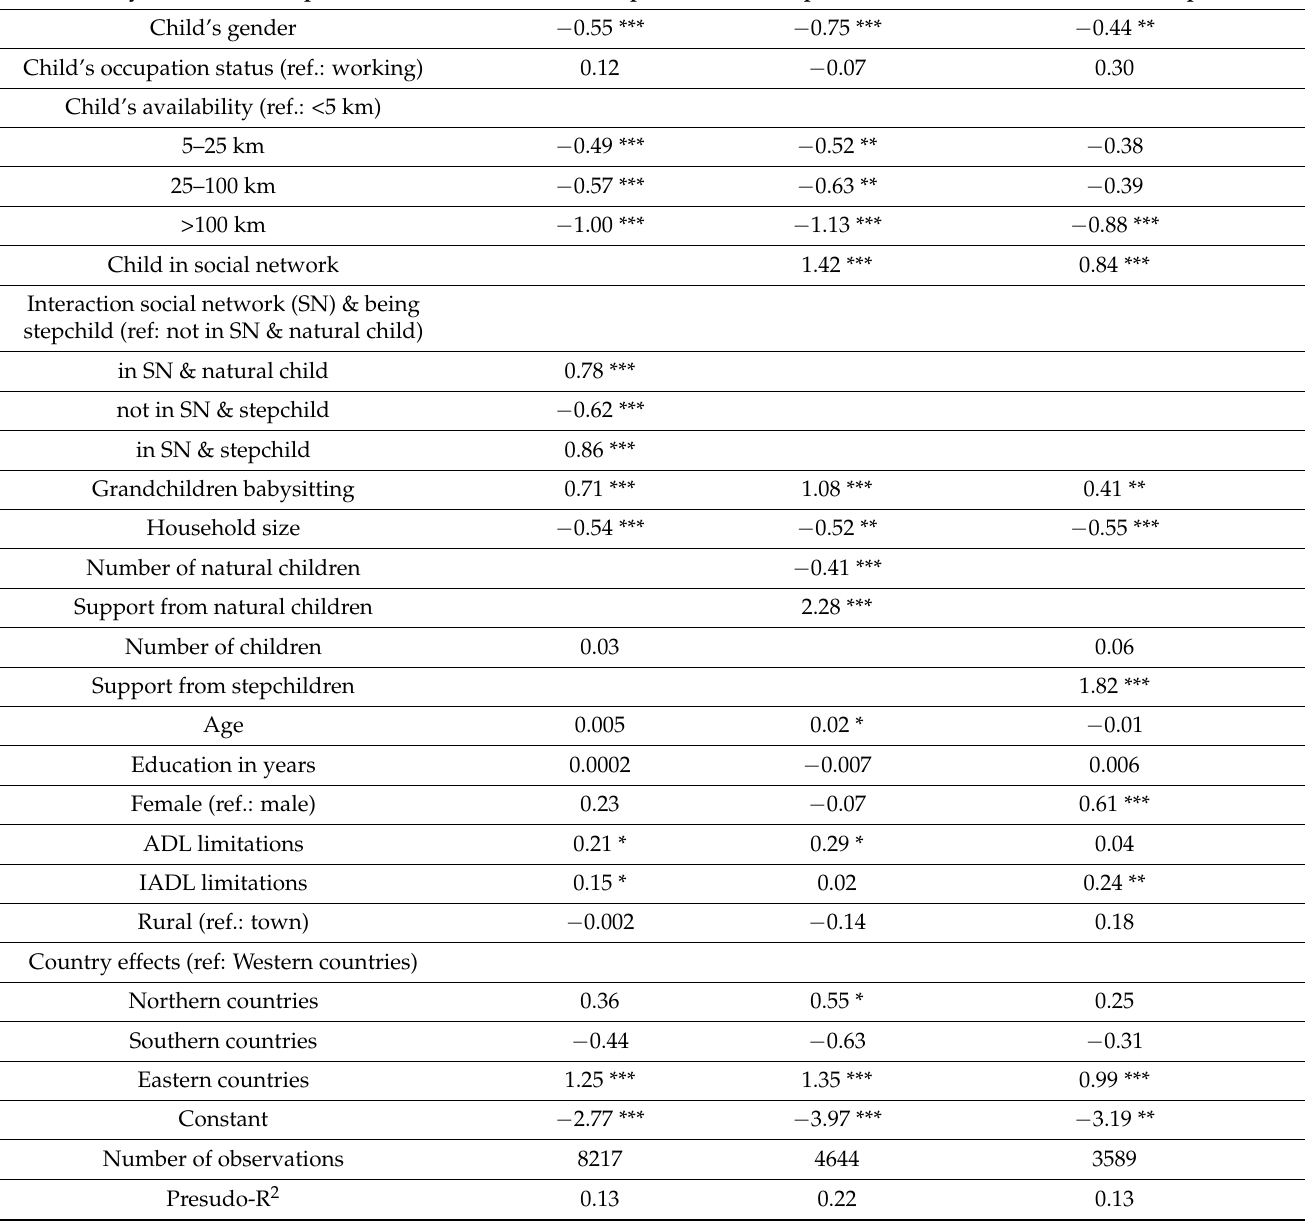
Table 3. Coefficients in the logistic regression models for non-financial support given by children in stepfamilies. Determinants of Non-Financial Support Given by Children in